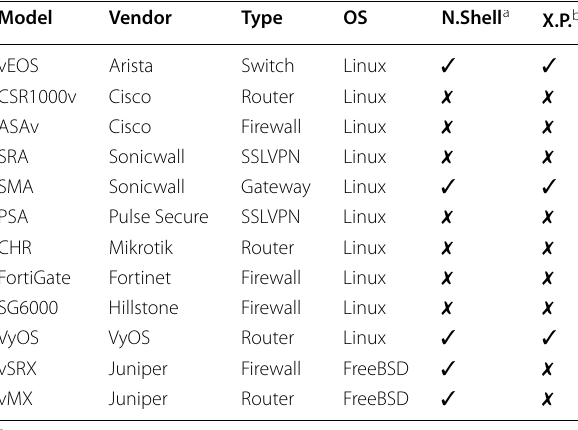
Table 1 Access control of popular virtualized network